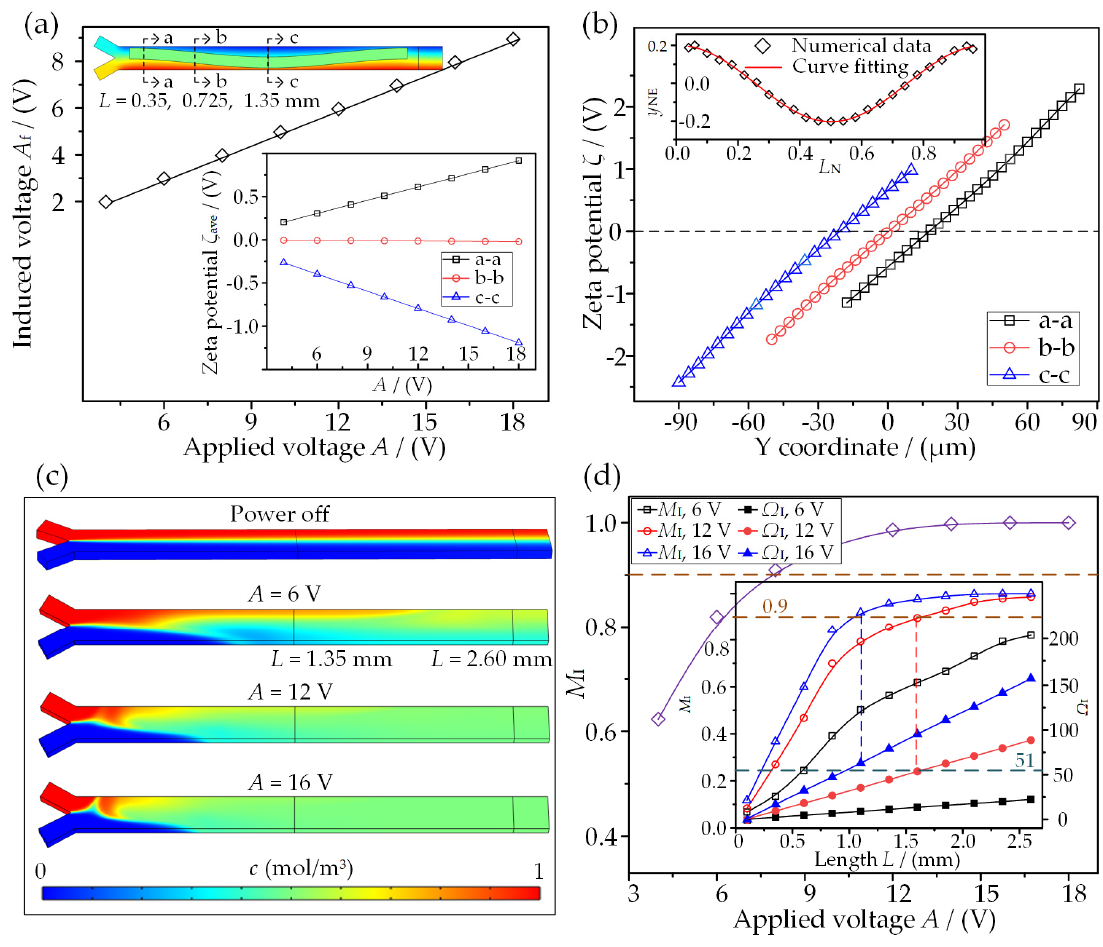
Figure 6. Influence of applied voltage A on mixing performance: ( a ) the induced voltage and the corresponding zeta potential on the SSFE; ( b ) variations of zeta potential on the SSFE; ( c ) concentration distributions under different voltages; ( d ) the mixing index as a function of A .